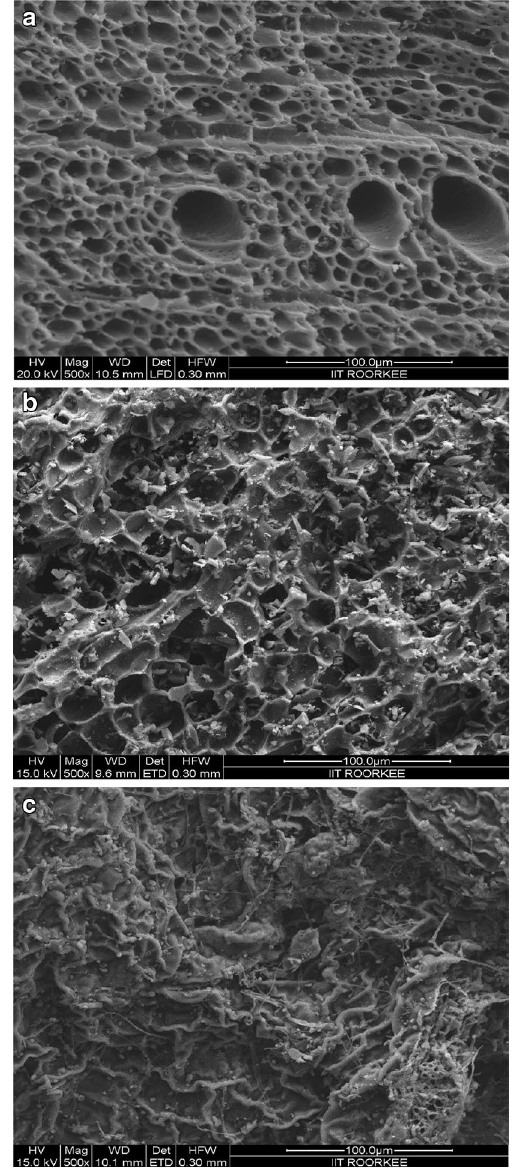
Fig. 2 a SEM image of tea waste biomass before surface modifica- tion, b SEM image of tea waste biomass after surface modification, and c SEM image of tea waste biomass after simultaneous adsorption of Cr(VI) and